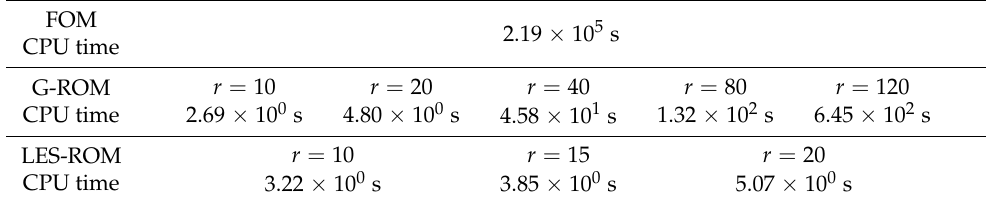
Table 6. CPU time for FOM, G-ROM, and LES-ROM in the online